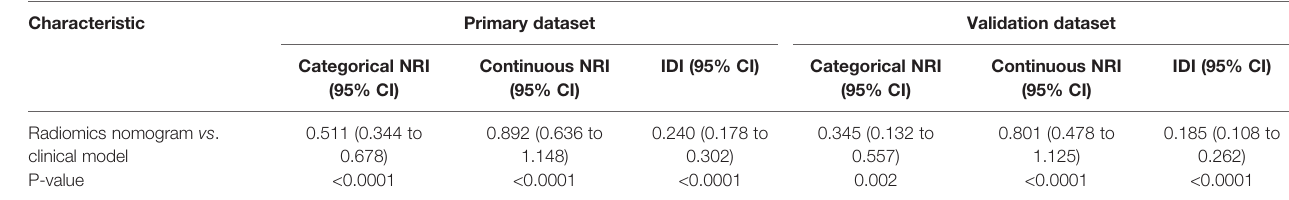
TABLE 5 | Evaluation of the radiomics nomogram with respect to NRI and IDI.